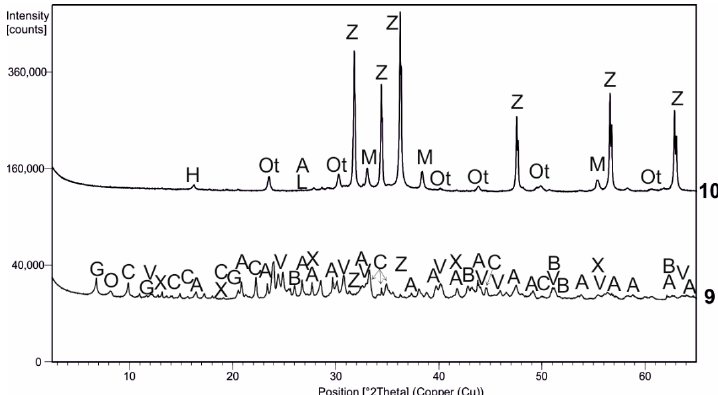
Figure 9. XRD pattern of sample No. 10 (Zn rectification) and No. 9 (sinter plant). Symbol explana- tion: A—anglesite, B—galena, C—challacolloite, G—gordaite, M—monteponite, O—osakaite, Ot—